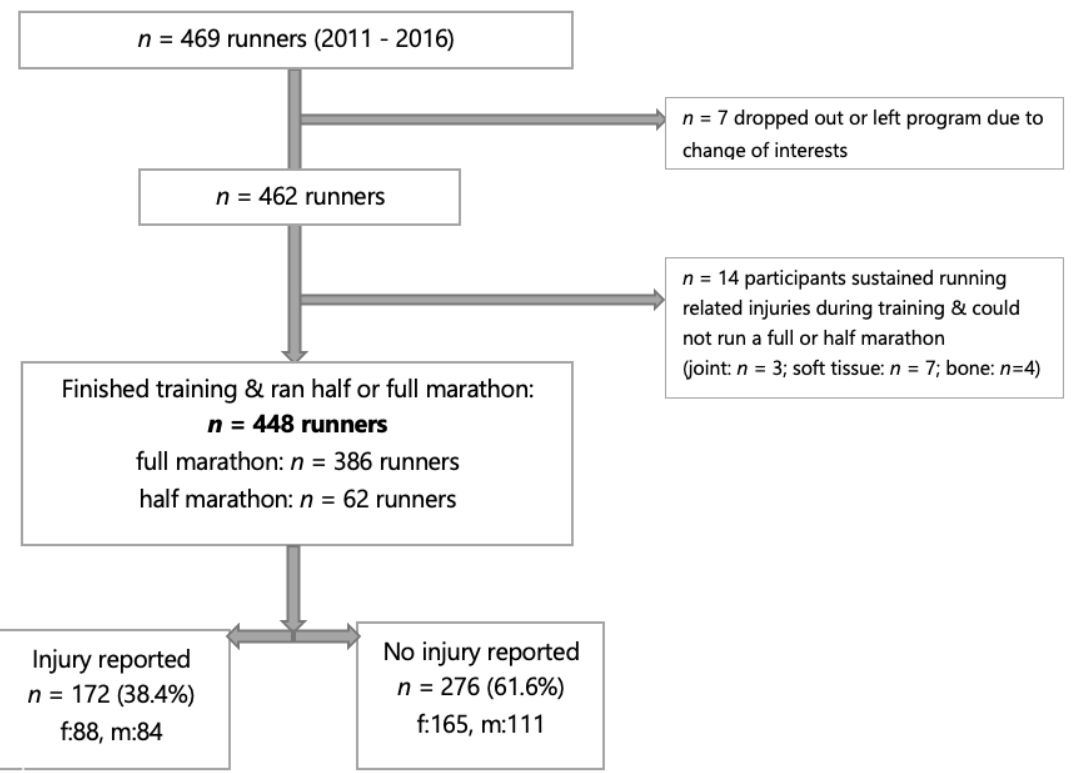
Figure 1. Participants who entered and completed the program, with or without injury.